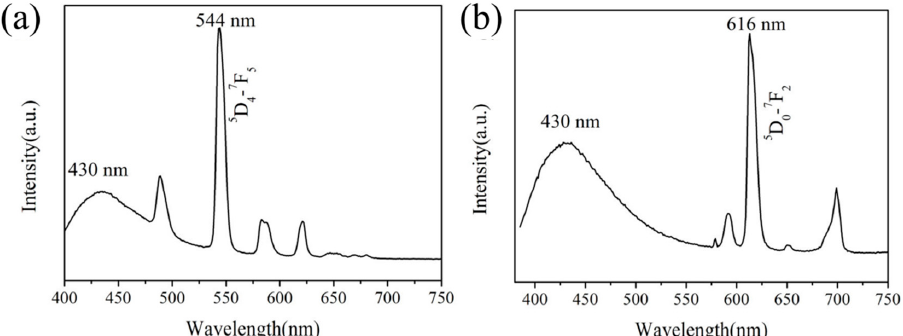
Figure 12. Emission spectra of Tb@UiO-66-Hybrid ( a ) and Eu@UiO-66-Hybrid ( b ) films excited at 330 nm. Reprinted with permission from Reference [75]. Copyright 2018 the American Chemical Society, (Washington, DC, USA).